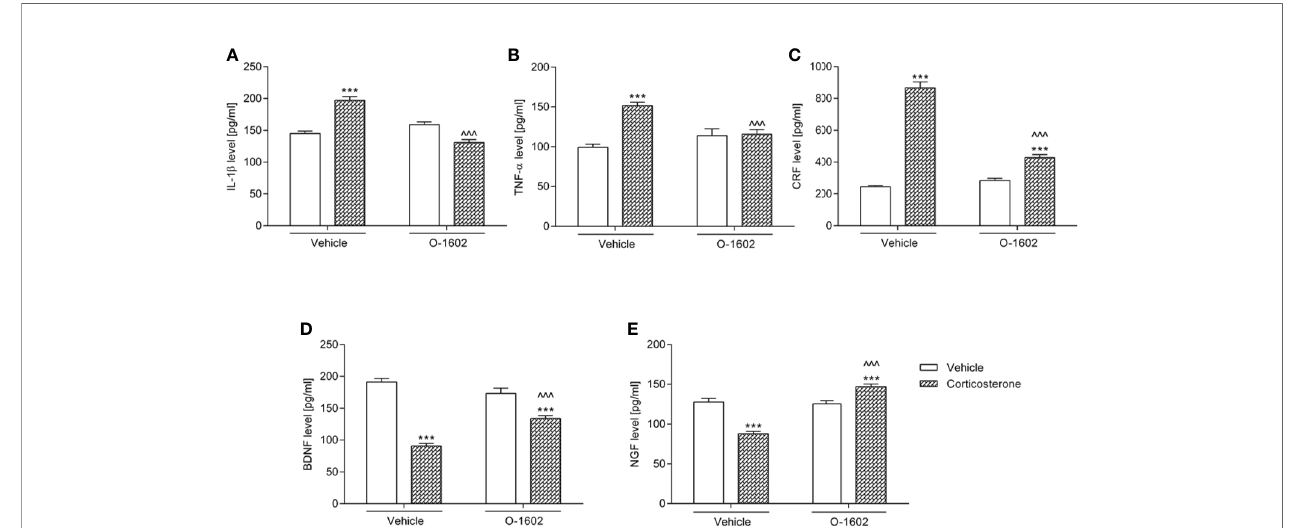
FIGURE 4 | In fl uence of the 7-day intravenous administration of O-1602 (0.25 mg/kg/day) on the levels of (A) interleukin 1- b (IL-1 b ) (B) tumor necrosis factor alpha (TNF- a ), (C) corticotropin-releasing factor (CRF), (D) brain-derived neurotrophic factor (BDNF), and (E) nerve growth factor (NGF) in the hippocampus of rats subjected to the 14-day corticosterone treatment (20 mg/kg/day, subcutaneously). The values represent the mean+SEM (n=14-15 animals per group). ***p<0.001 versus vehicle-treated group, ^^^p<0.001 versus corticosterone-treated group (Bonferroni ’ s post hoc